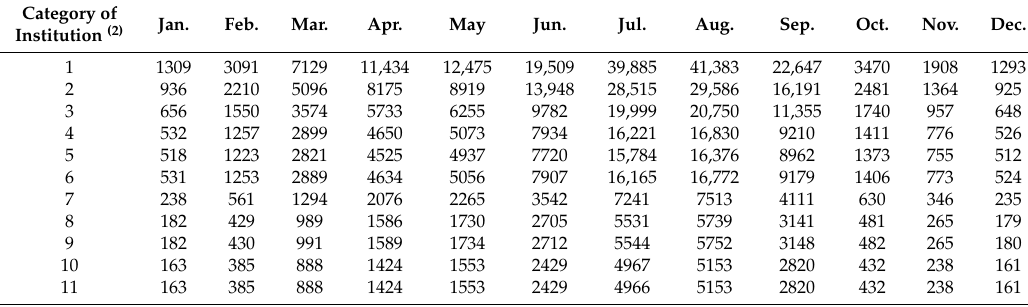
Table 3. Potential volume of monthly rooftop RWH (m 3 ) from each large public institution. Category of Jan. Feb. Institution (2)